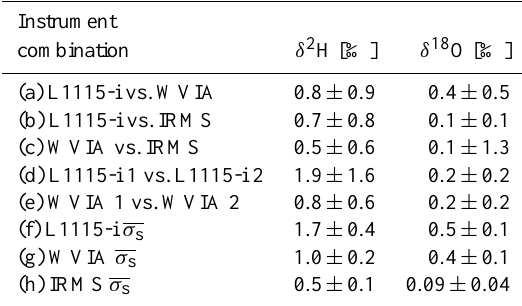
Table 3. Results from the delta-scale linearity experiment. The two laser systems L1115-i and WVIA were compared to IRMS using ten standards, which were measured on all the instruments twice (run 1 and run 2). The average differences over the ten standards for the different instrument combinations are listed. σ s indicates the average standard deviation of the measurements over all working standard runs. The standard deviation of the drift standard measure- ments over the individual runs was 1.2‰ (0.7‰) for δ 2 H of L1115- i (WVIA) and 0.3‰ (0.3‰) for δ 18 O of L1115-i